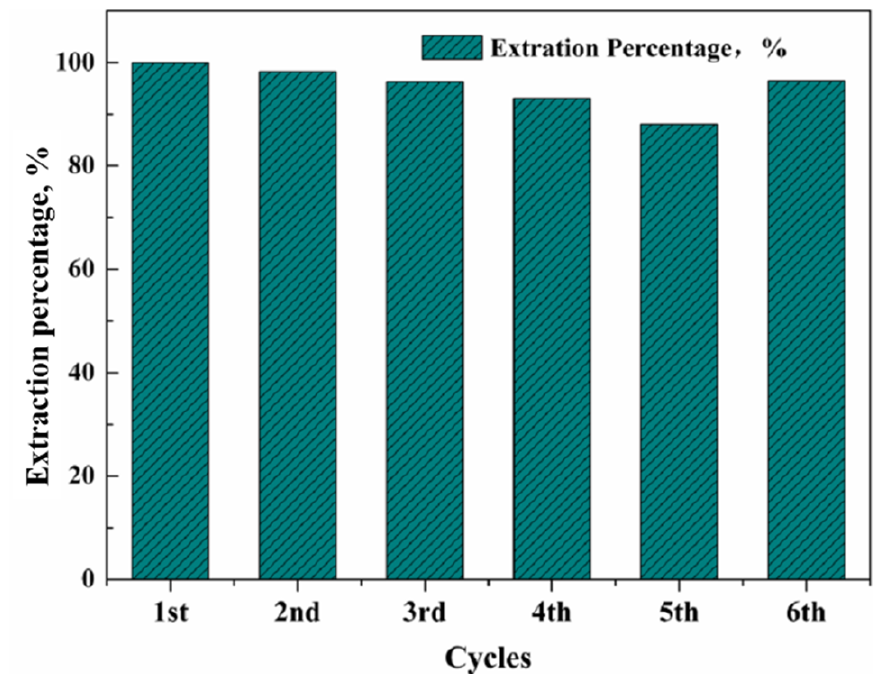
Figure 10. Stability evaluation of the SLM system. ([Ga(III)]feed:400 mg/L, Acidity: 6 M HCl, Carrier: Bif-IL (R 4 NCy), Strip: pH = 1; Time: 8 h; Carriers were impregnated in the 6th cycle).